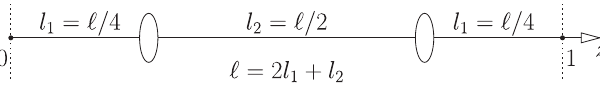
FIG. 2. Equivalent optical scheme of the unfolded symmetric cavity with two